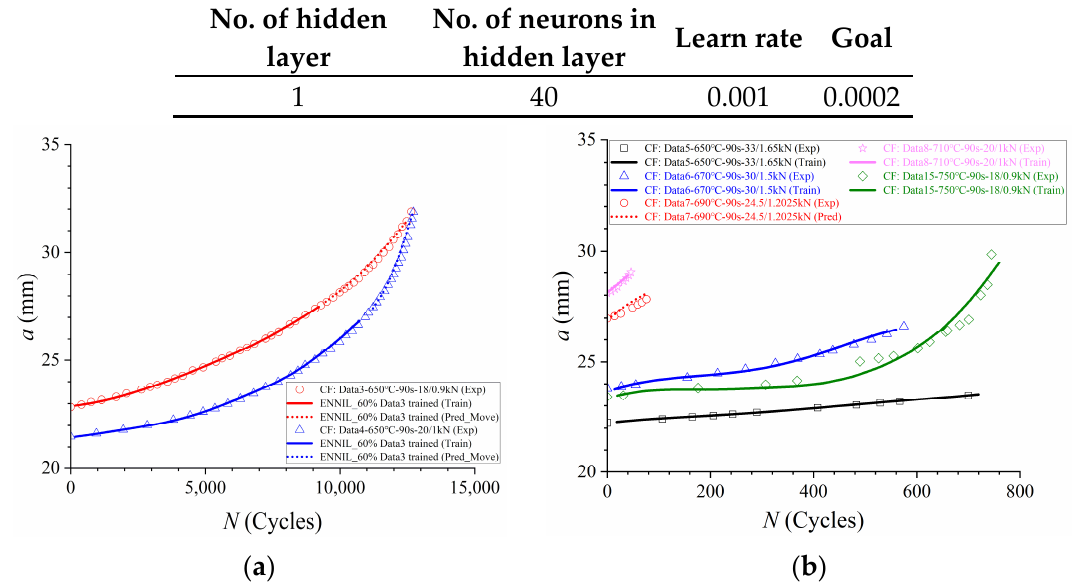
Figure 15. a - N curves prediction using ENNIL scheme for data measured under: ( a ) the same temperature but different loading conditions; ( b ) different loading conditions and temperature.